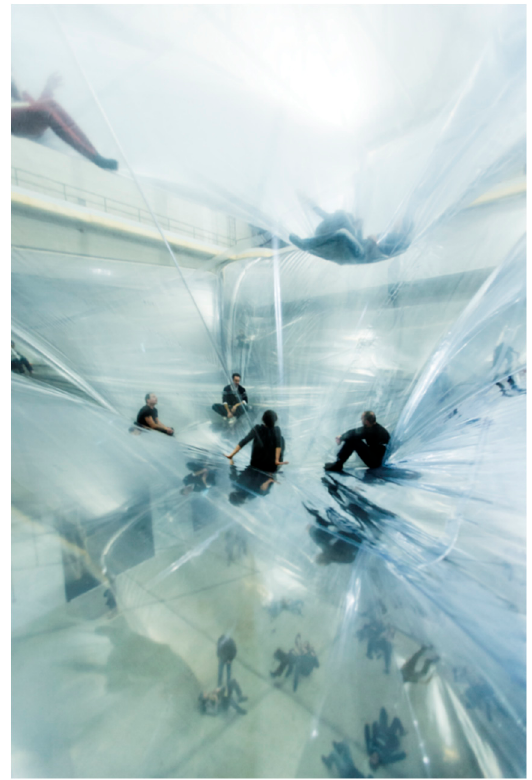
Figure 3. Tomás Saraceno, On Space Time Foam, 2012. Exhibition view Hangar Bicocca, Milan, Italy. Solo exhibition curated by Andrea Lissoni. Courtesy the artist; Tanya Bonakdar Gallery, New York; Andersen’s Contemporary, Copenhagen; Ruth Benzacar Galería de Arte, Buenos Aires; Pinksummer contemporary art, Genoa; Esther Schipper, Berlin. © Photography by Studio Tomás Saraceno, 2012.